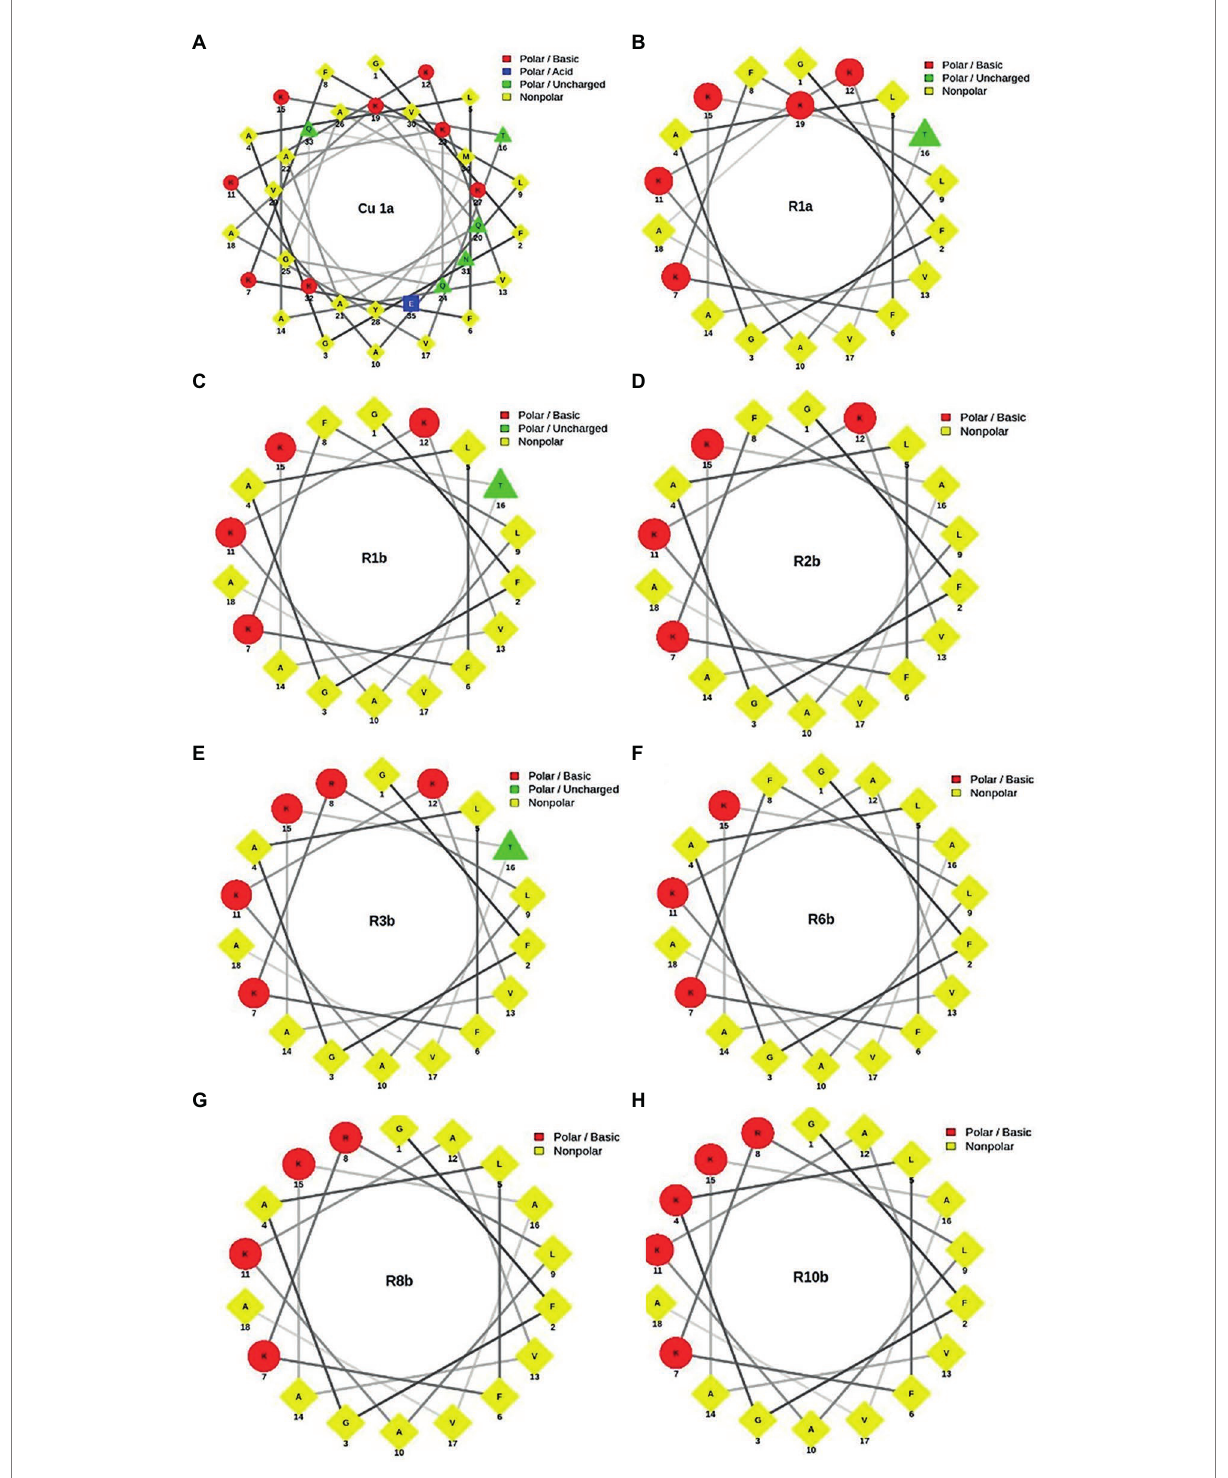
FIGURE 1 Helical wheel projection of analogous synthetic peptides designed based on the Cu-1a peptide sequence. In red, the basic polar amino acid residues; in blue, the acid polar amino acids; in green, the uncharged polar amino acids; and in yellow, the nonpolar amino acids. (A) Cu-1a; (B) R1a; (C) R1b; (D) R2b; (E) R3b; (F) R6b; (G) R8b; and (H)